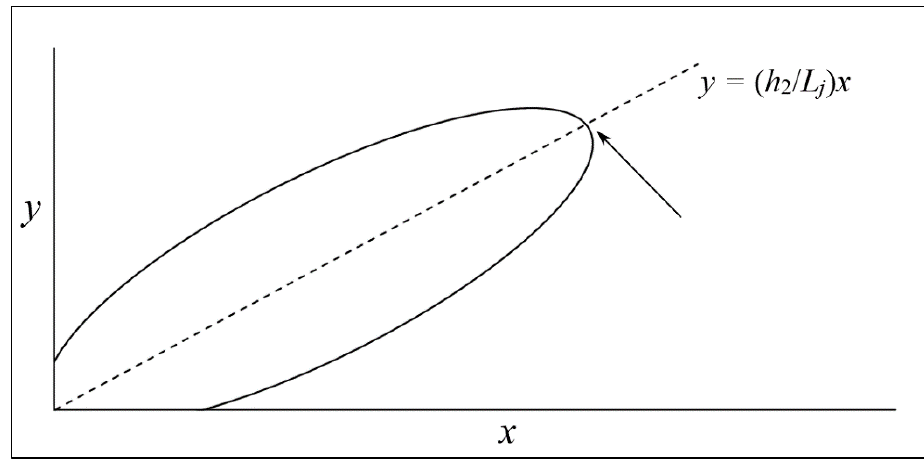
Figure 4. Jump surface profile symmetry and the upper streamline.